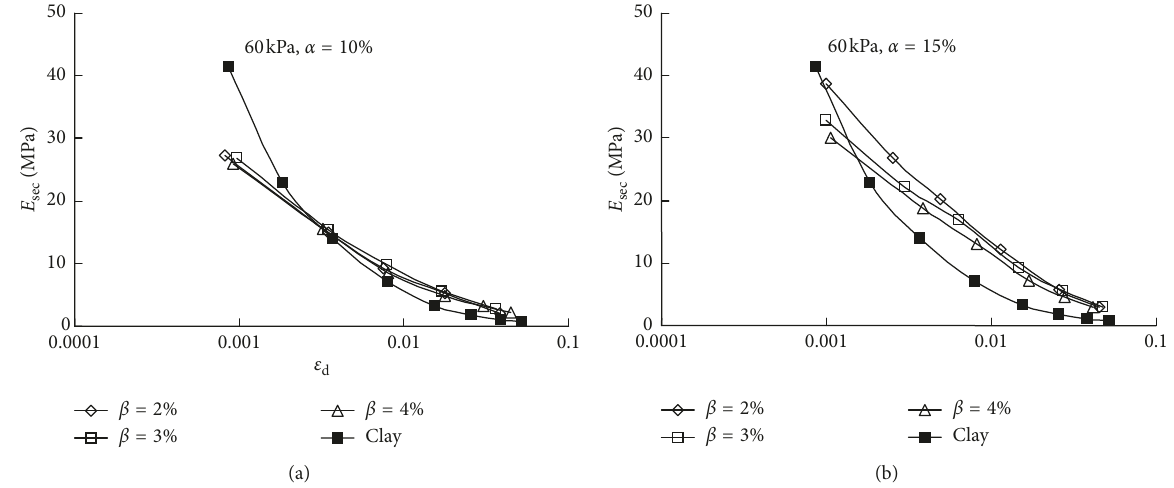
Figure 10: The curve of E